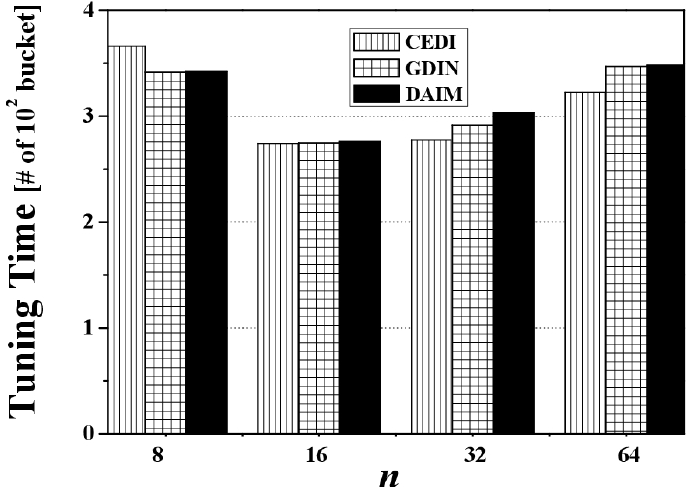
Figure 14. The comparison of the tuning time over various n